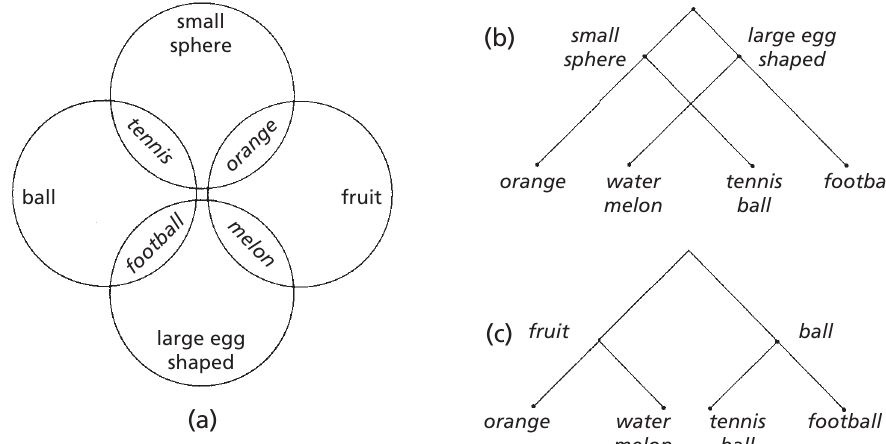
Figure 2. Overlapping Subsets. ( a ) Partitions of the items, { tennis ball , orange , football , water melon }, into the overlapping subsets, small sphere , large egg shaped , ball , and fruit ; ( b ) partition of the items into small sphere and large egg shaped , viewed as a tree; ( c ) partition of the items into fruit and ball , viewed as a tree. Source: Adapted by R.P.G. from { A City is Not a Tree }